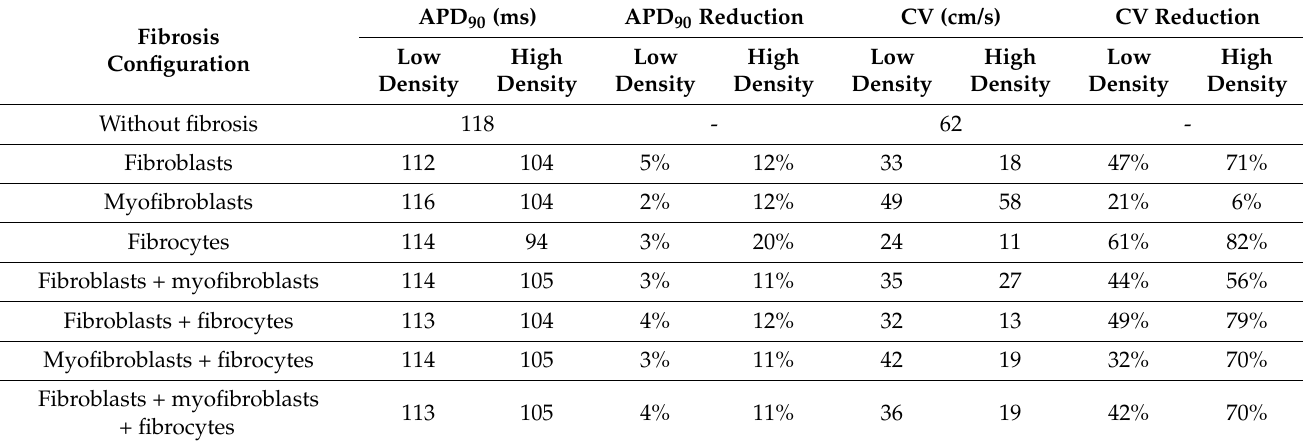
Table 2. Fibrosis effects on the APD 90 and conduction velocity (CV), for each fibrosis configuration at low and high density.